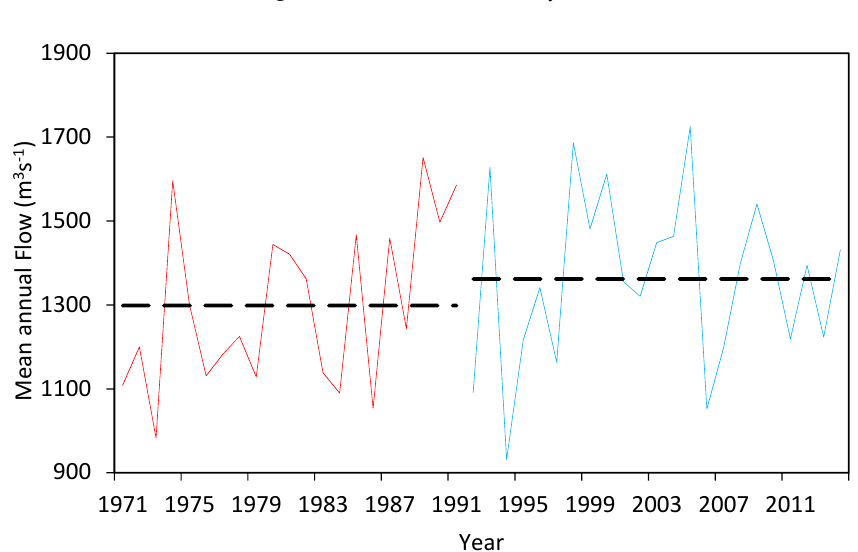
Figure 4. Mean annual flow at Shigu station from 1971 to 2014 (since 1992, the average flow has shifted from 1298 to 1362 m 3 s − 1 ).